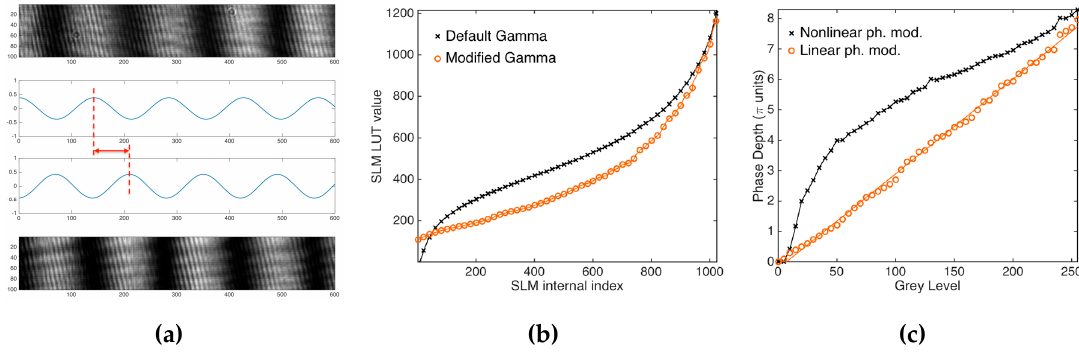
Figure 3. ( a ) Interferogram obtained when two different gray levels are sent to the top and bottom halves of the SLM display (Figure 2b). The phase difference is measured from the detected fringe shift. ( b ) Look-up tables (LUTs), also named gamma curves, to control the response of the SLM display and ( c ) measured phase modulation depth. Line curves with cross markers from (b) and (c) correspond to the initial measurement when the gamma curve provided by the manufacturer is used (default gamma). The corresponding phase modulation slightly exceeds 8 π radians but with a nonlinear response. Line curves with circles from (b) and (c) correspond to the modified gamma curve that achieves a linear phase modulation of the display. The LCoS display was illuminated with λ G = 514 nm.